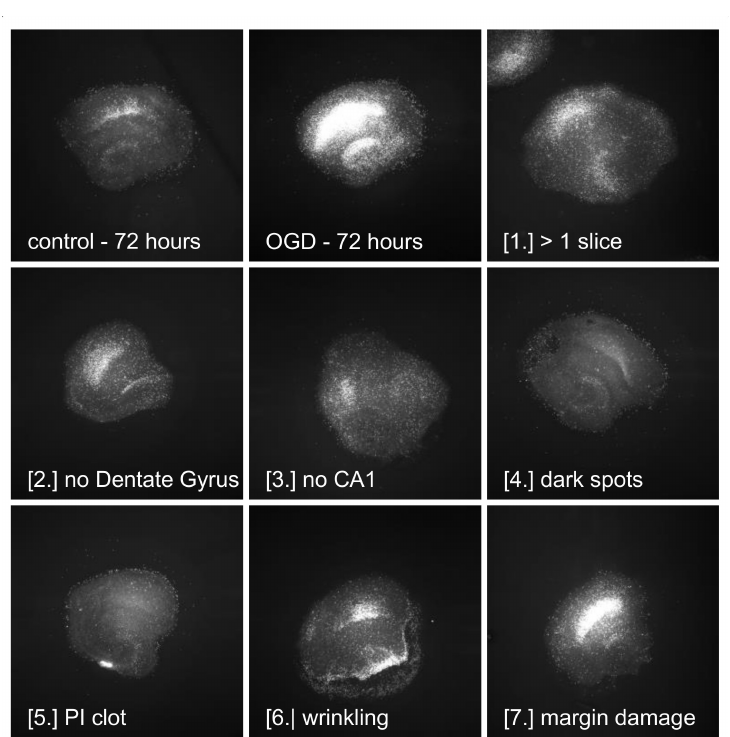
Figure A1. Example slices for our exclusion criteria. Upper left and middle picture show normal slices at 72 h after OGD or control, respectively. [1.] Image files with more than one slice were excluded.